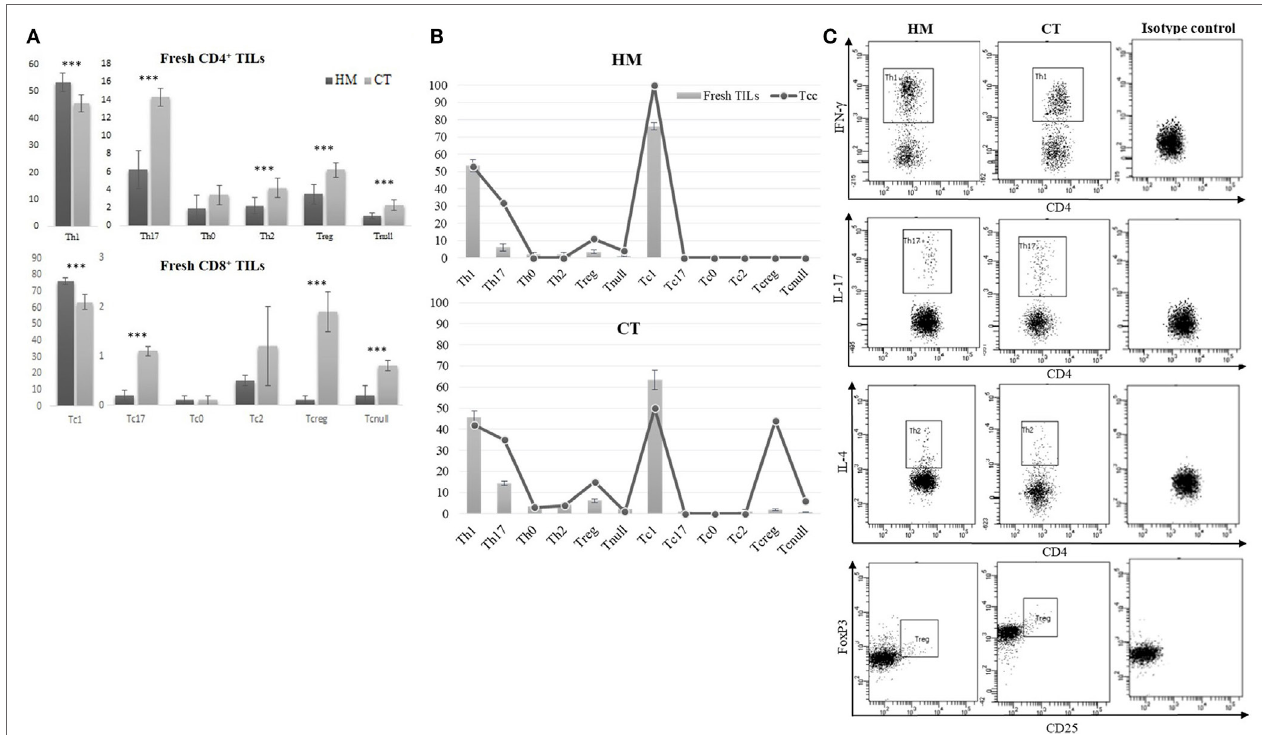
FigUre 6 | Cytofluorimetric analysis of fresh TILs isolated from tissue specimens. (a) Different distribution of fresh CD4 + and CD8 + TILs subsets, isolated from the healthy mucosa (HM) of 30 colorectal cancer (CRC) patients and the central tumor (CT) of 20 (out of 30). Results are reported as percentages (mean ± SD) and statistical analysis was performed using the Student’s t -test. The asterisks (***) represent a p < 0.001. (b) Comparison of CD4 + and CD8 + T cell subsets’ distribution, obtained by analysis of fresh TILs and Tcc obtained by cloning, in HM and CT of CRC patients. (c) A representative cytofluorimetric analysis of fresh T helper subsets (Th1, Th17, Th2, Treg) observed in HM and CT of the same CRC